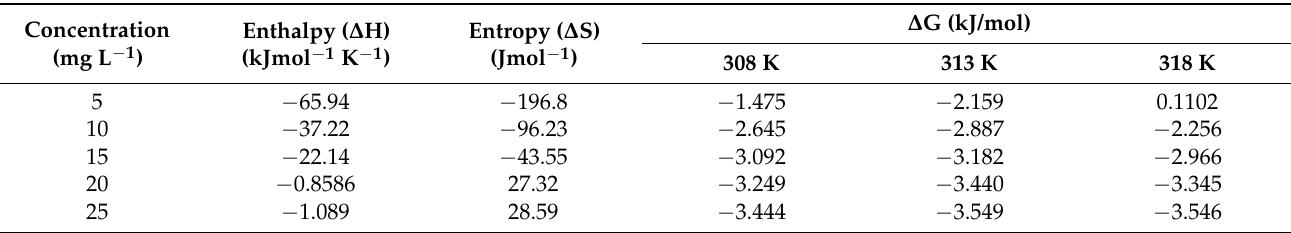
Table 6. Thermodynamic parameters for the adsorption of CV dye on the IZNC.